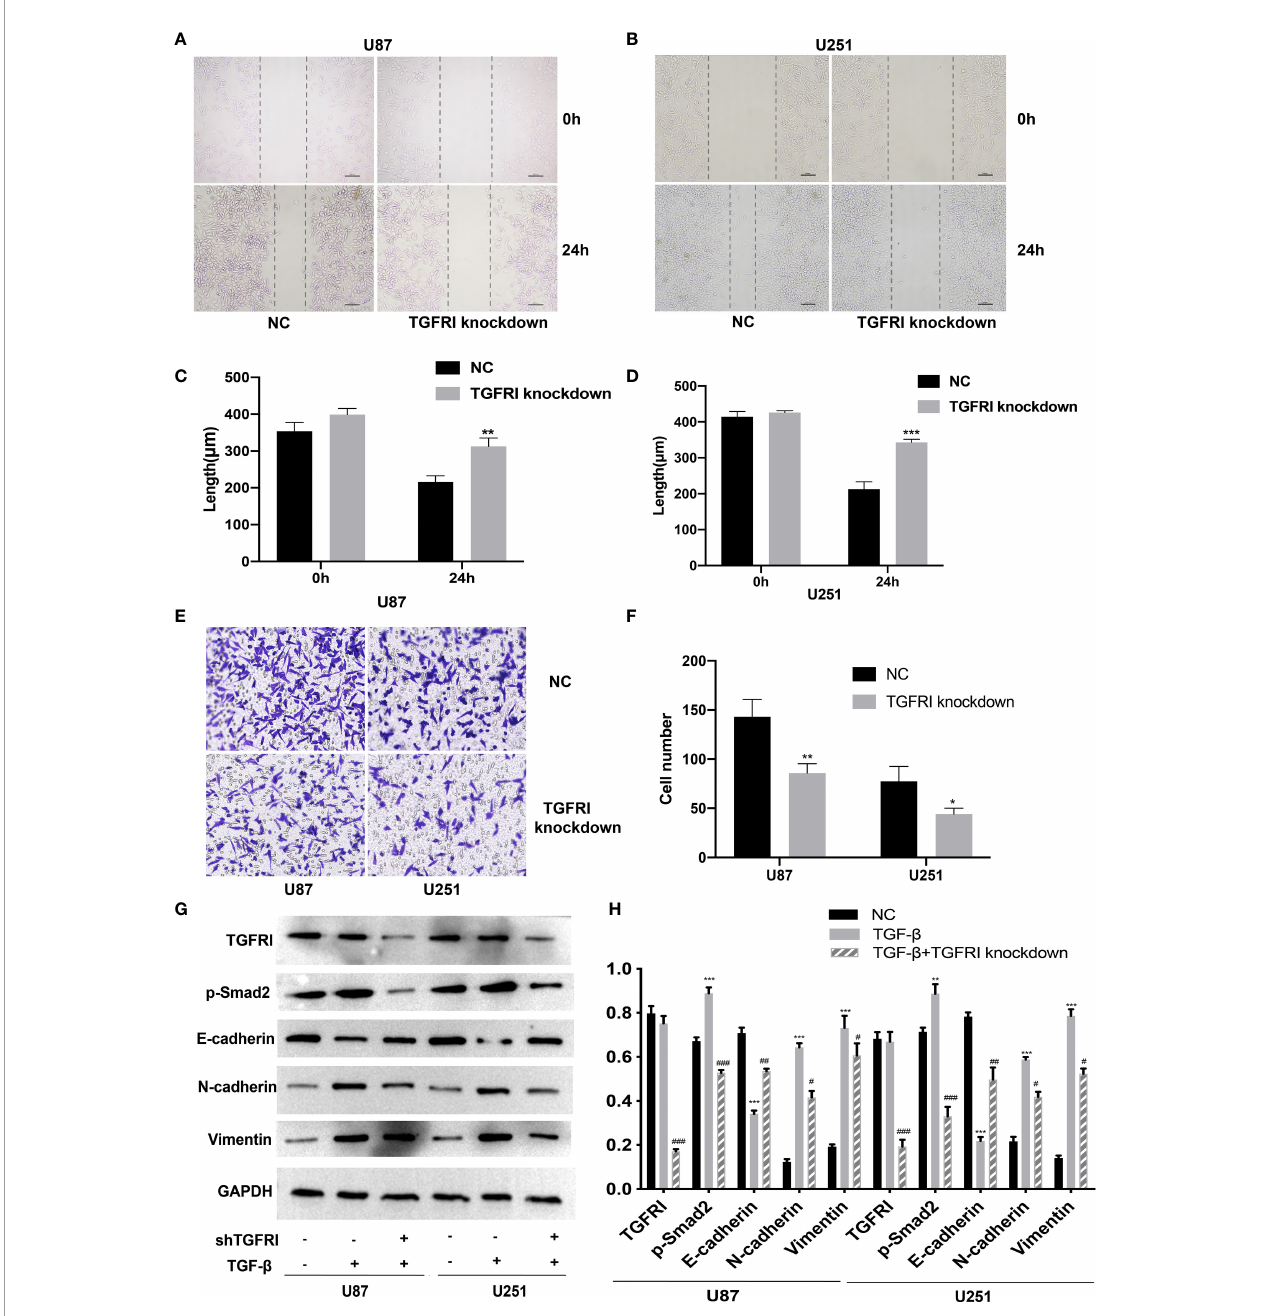
FIGURE 3 | MICAL2 promotes migration and invasion of glioma cells. (A – D) The effect of MICAL2 on cell migration was determined via wound-healing assay. Comparing with the NC group, the length of wound in MICAL2 knockdown group in U87 ( p < 0.001) and U251 ( p < 0.05) were signi fi cantly higher after 24 h of healing. (E, F) Transwell migration assay was used to detected cell invasion ability of GBM cells. Cell number of MICAL2 knockdown group were decreased in U87 ( p < 0.05) and U251 ( p < 0.05) cell lines compared with the NC group. (G, H) MICAL2, p-Smad2, and EMT relative protein (E-cadherin, N-cadherin, and vimentin) expression were detected via Western blotting. Data are shown as the means ± SEM of three experiments. Asterisk represents TGF- b -induced group comparing with the NC group; number sign represents TGF- b -induced and MICAL2-knockdown group comparing with TGF- b -induced group; *, # p < 0.05, **, ## p < 0.01, ***, ### p <